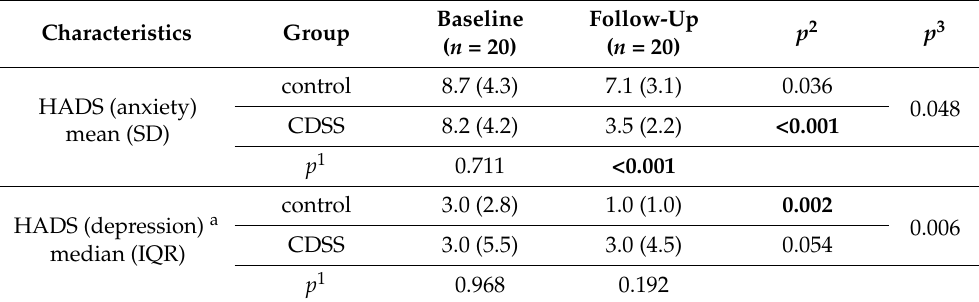
Table 5. HADS at baseline and